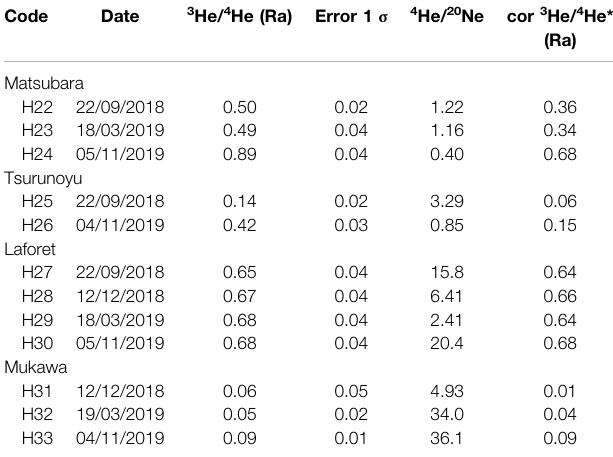
TABLE 3 | Helium isotopes and helium/neon ratios of natural springs after the M6.7 earthquake in Hokkaido, Japan. Code